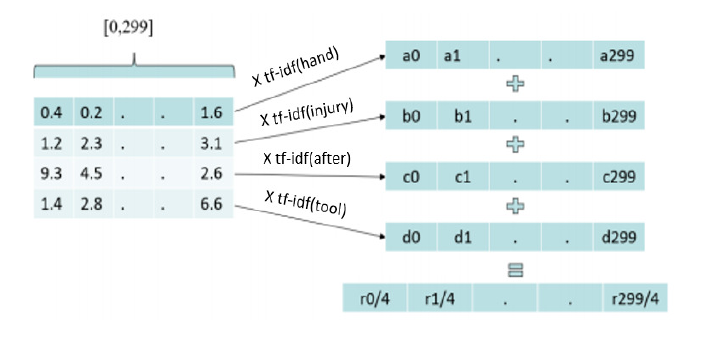
Figure 3. Converting each word to a vector of length 300.